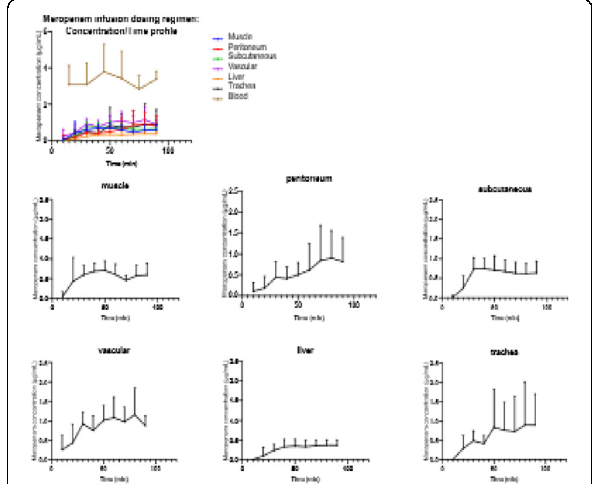
Fig. 1 (abstract 000840). Meropenem continuous infusion dosing regimen: concentration/time